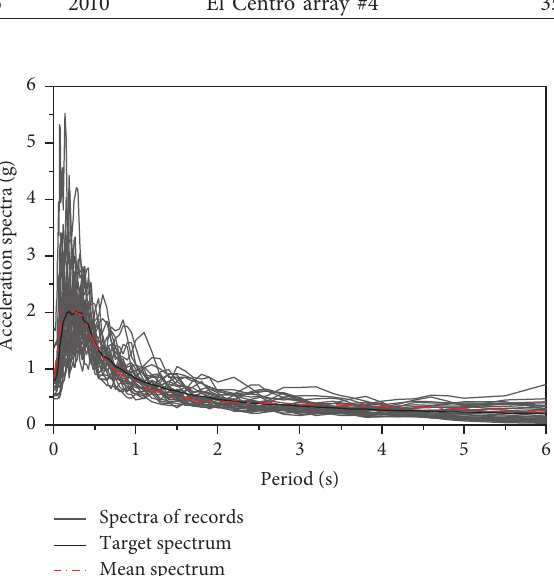
Figure 4: Acceleration spectra of far-fault earthquake records, mean spectrum, and target response spectrum.